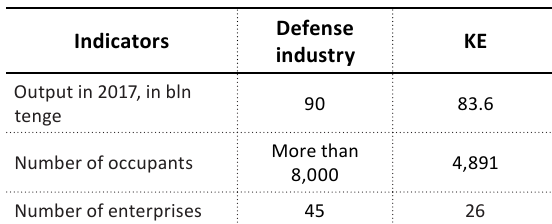
Defense KE industry 90 83.6 More than 4,891 8,000